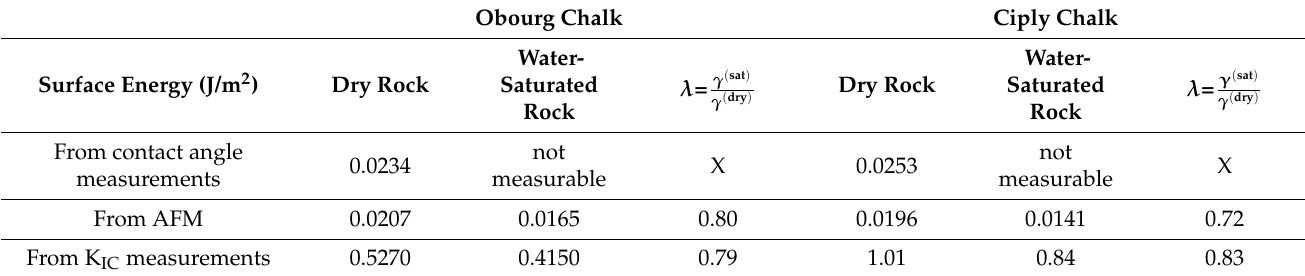
Table 8. Surface energy derived from the three different methods tested in this work. Obourg Chalk Ciply Chalk Water- Saturated Surface Energy (J/m 2 ) Dry Rock From contact angle measurements From AFM From K IC